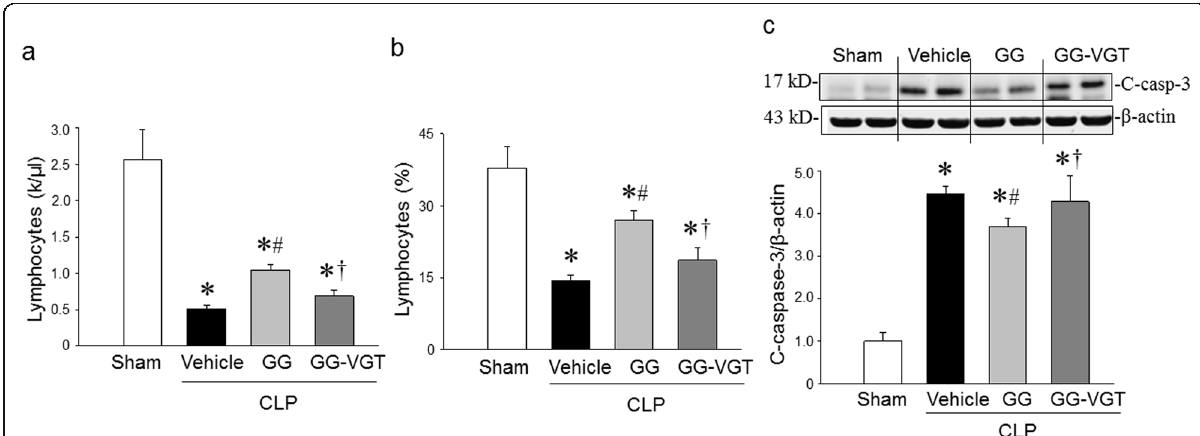
Fig. 3 Ghrelin and GH in combination attenuate lymphopenia in aged rats with sepsis in a vagus nerve dependent manner. Rats were subjected to sham or CLP operation and treated with vehicle (normal saline) or GG (ghrelin 80 nmol/kg, GH 50 μ g/kg) at 5 h after CLP. In an additional group of rats, vagotomy was performed at the time of CLP and treated with GG at 5 h after CLP. Blood and spleens were collected at 20 h after CLP. a, b Circulating lymphocytes were measured using a hematology analyzer. Data are expressed as mean ± SEM ( n = 4 – 6 rats/group). c The levels of cleaved caspase-3 in the spleen were determined by western blotting. The representative western blot images are shown. Sham was normalized as 1 in western blot analysis. Data are expressed as mean ± SEM ( n = 4 – 5 rats/group). * P < 0.05 vs. sham; # P < 0.05 vs. CLP with vehicle treatment; † P < 0.05 vs. CLP with GG treatment